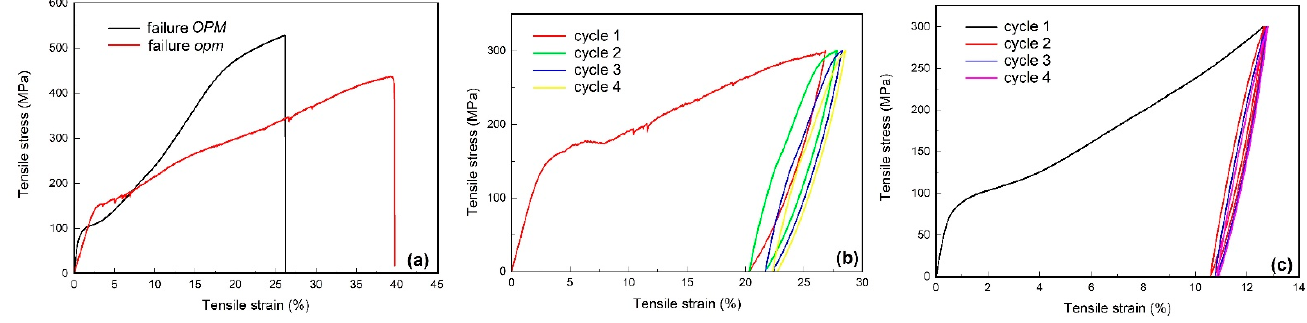
Figure 3. Tensile stress–strain curves: ( a ) failure of opm and OPM specimens; ( b ) four loading–un- loading cycles, opm specimen, up to 300 MPa; ( c ) four loading–unloading cycles, OPM specimen, up to 300 MPa.